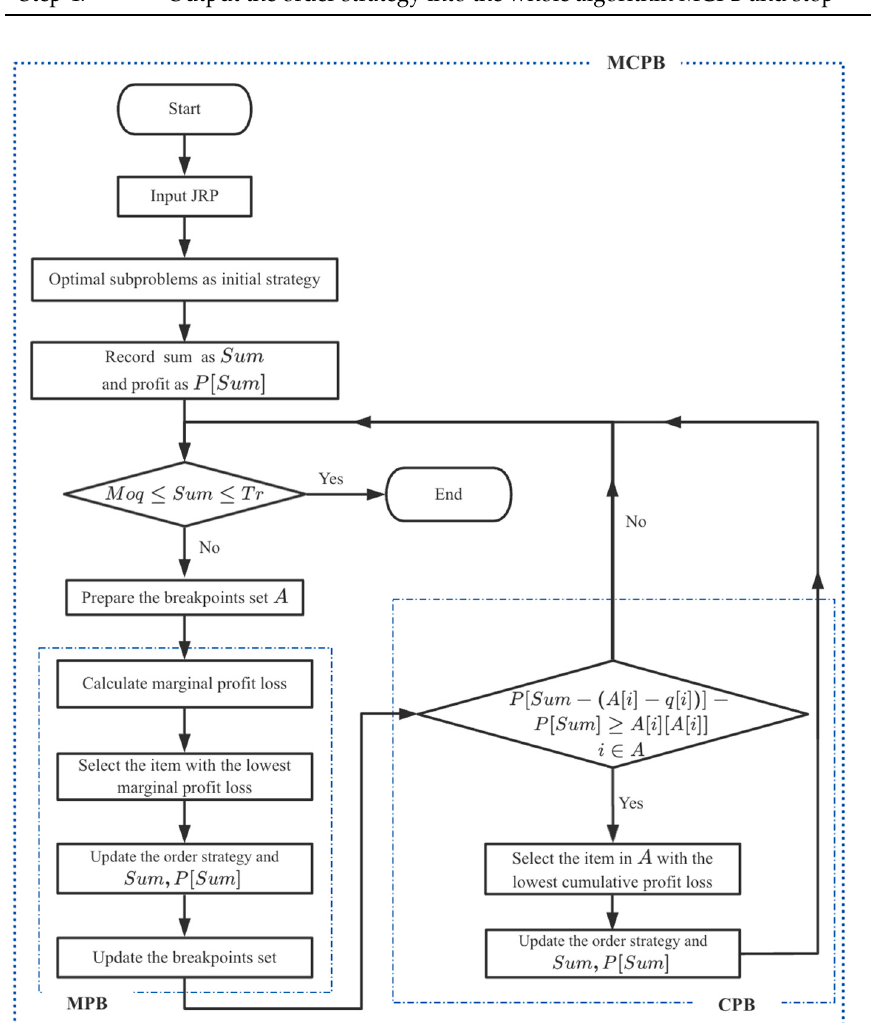
Figure 1. Flow chart of